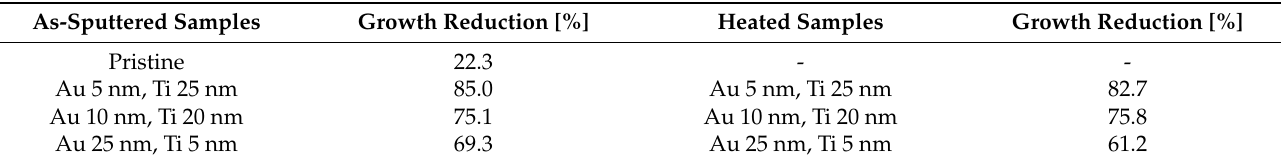
Figure 13 represents images of E. coli CFU on LB agar plates inoculated after incubation with selected samples. Figure 13 shows a reduction in bacterial growth after 24 h of contact with PLLA-modified samples. The sample, which was thermally stressed, exhibited an effect on the shape and size of the bacterial colonies. Compared to other images, the boundaries of the colonies are blurred. The same difference in shape for the bacteria that were in contact with the samples was observed for all combinations of metal thicknesses used before and after heating. The photocatalytically active layer of titanium dioxide formed on their surface after sputtering due to contact with air, which enhanced the antibacterial properties of the samples. Because daylight with no further irradiation supplies the samples with relatively low energy and TiO 2 is present in the sample in small amounts, the photocatalytic activity was not very high. After 2 h of contact, no bactericidal effects were observed and, therefore, a longer, 24-h treatment was required. The results, thus, agree with the data found in the literature.